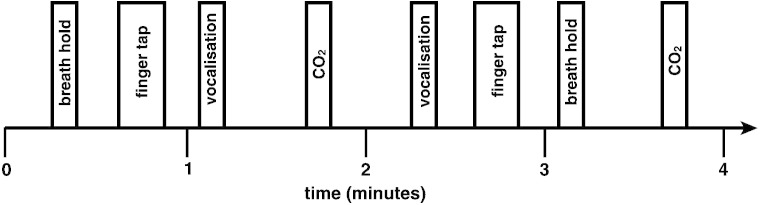
Example four minutes of the BOLD sequence, repeated throughout the acquisition. The order of the breath holds and vocalisations was semi-randomised between the finger opposition and CO2 stimuli.